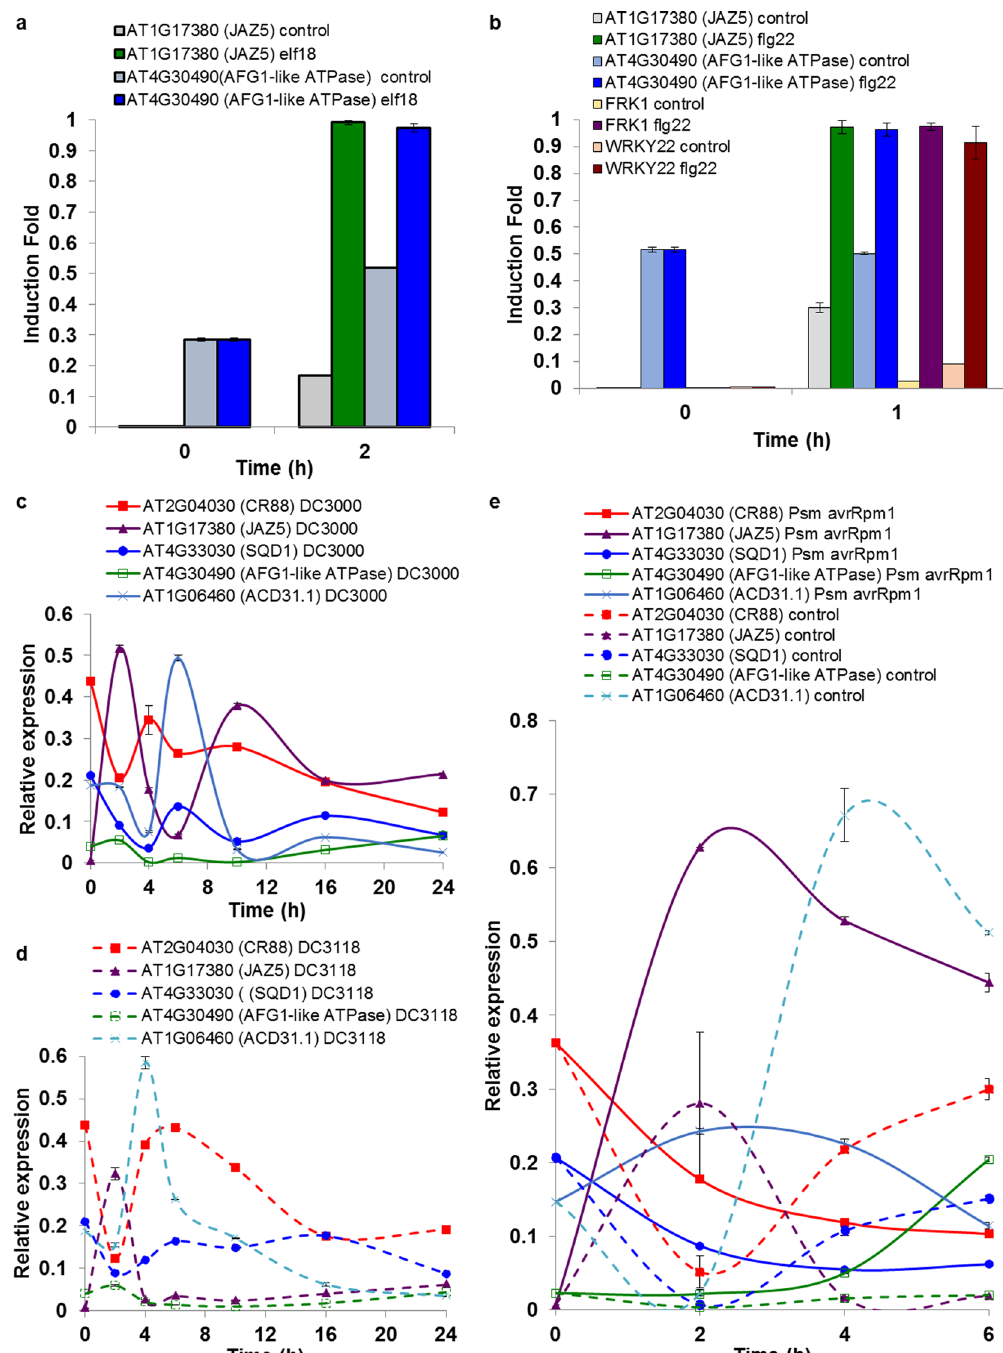
Figure 4. qRT-PCR analyses of five selected genes upon treatments with diverse stimuli and bacterial pathogens. Accumulation transcripts of the indicated genes is revealed upon treatments with elf18 or control ( a ), flg22 ( b ), DC3000 ( c ), DC3118 ( d ) and Pseudomonas syringae expressing AvrRpm1 ( e ). Data represent the mean and standard error of two technical